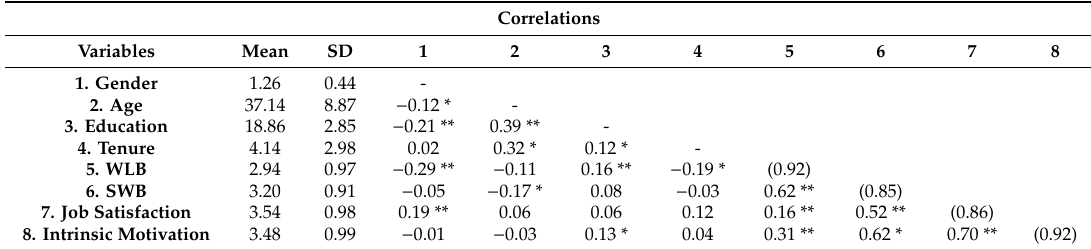
Table 2. Mean, Standard Deviation, Correlations of Variables.